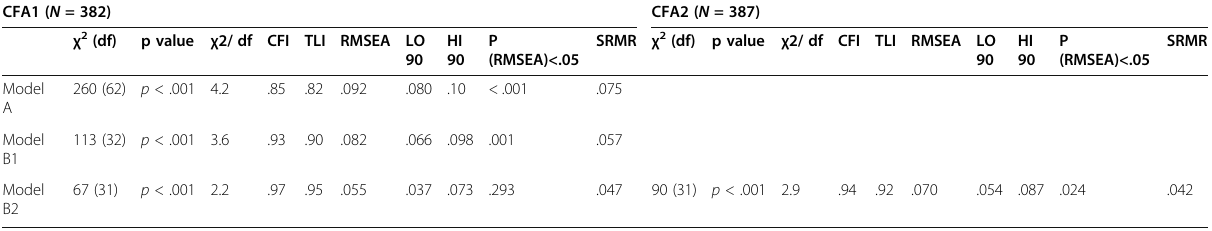
Table 2 Goodness of fit indices for the model of the confirmatory factor analyses for the PS-US CFA1 ( N = 382) CFA2 ( N =